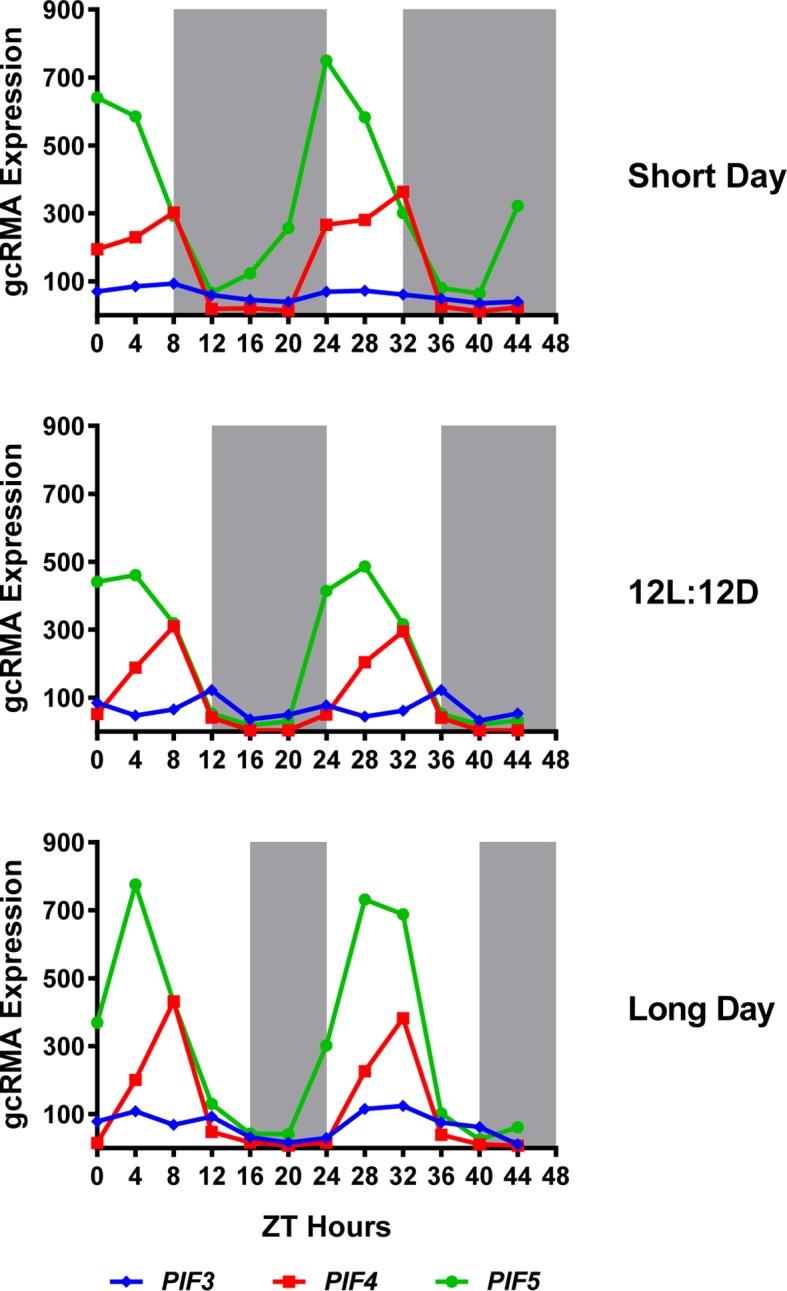
Expression of PIF3, PIF4 and PIF5 under multiple photoperiods.Daily expression (represented as gcRMA values) of PIF3, PIF4, and PIF5 under short day, 12L:12D (Col_LDHH) and long day conditions were generated from microarray data (Diurnal database, http://diurnal.mocklerlab.org/, Mockler et al., 2007). Note high levels of PIFs (e.g. PIF4s) expression at ZT8 are at dusk in short days, while shifted gradually to the middle of the day when day length increases (e.g. long day conditions). Grey shadings indicate dark periods.